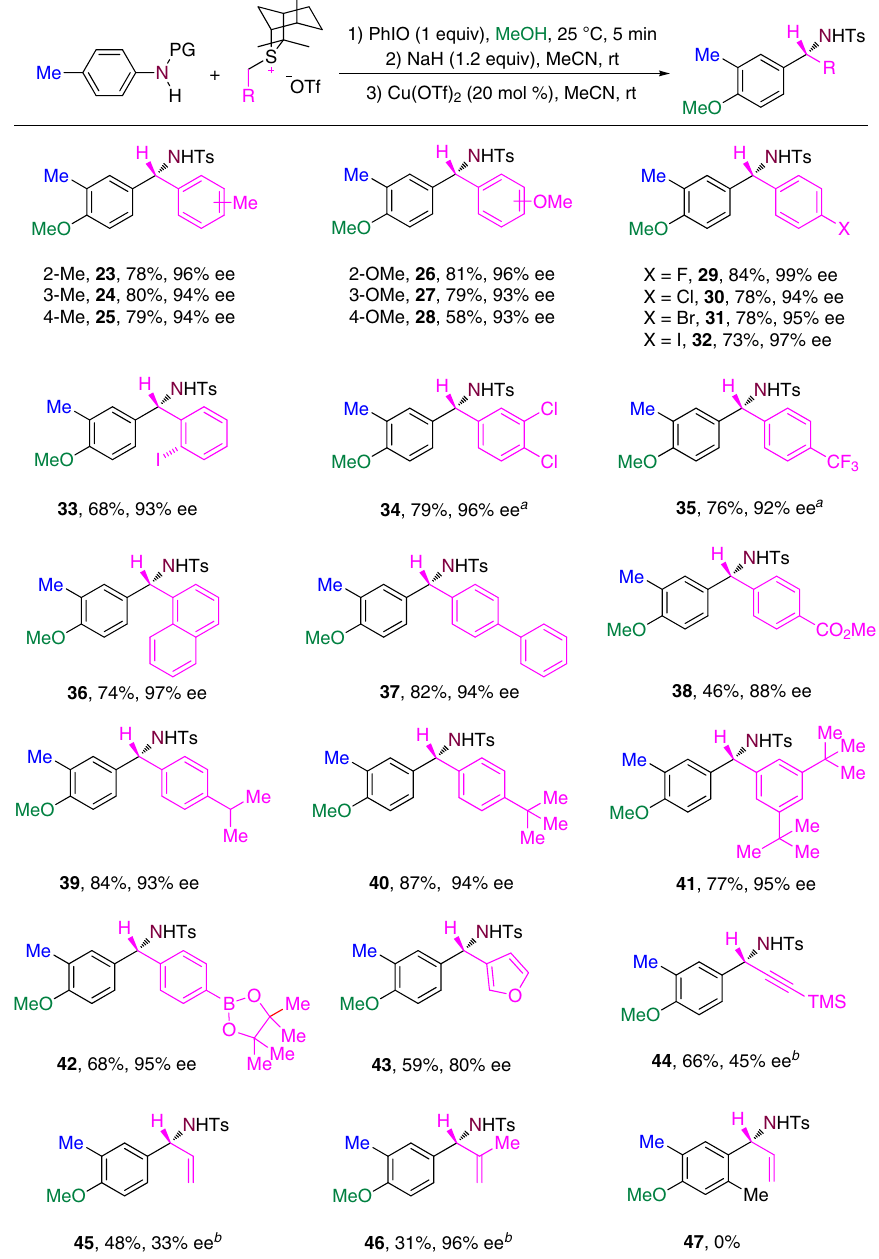
Fig. 5 Scope of chiral sulfonium salts. Ts